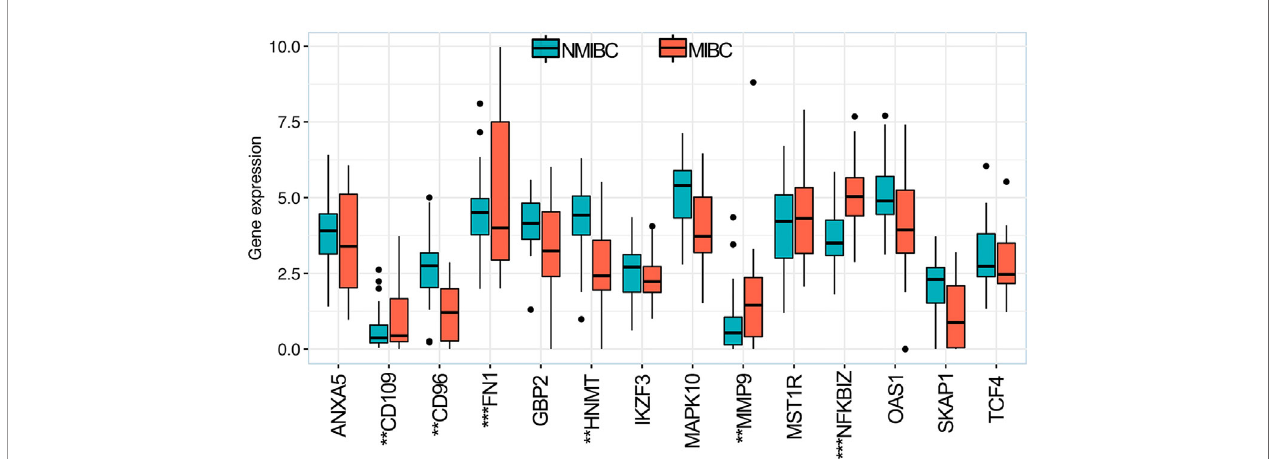
FIGURE 8 | Expression levels of 14 overall survival-associated immune genes in NMIBC and MIBC using the RNA-sequence data of bladder cancer samples in our center. ** P < 0.01, *** P < 0.001. NMIBC, non-muscle-invasive bladder cancer; MIBC, muscle-invasive bladder